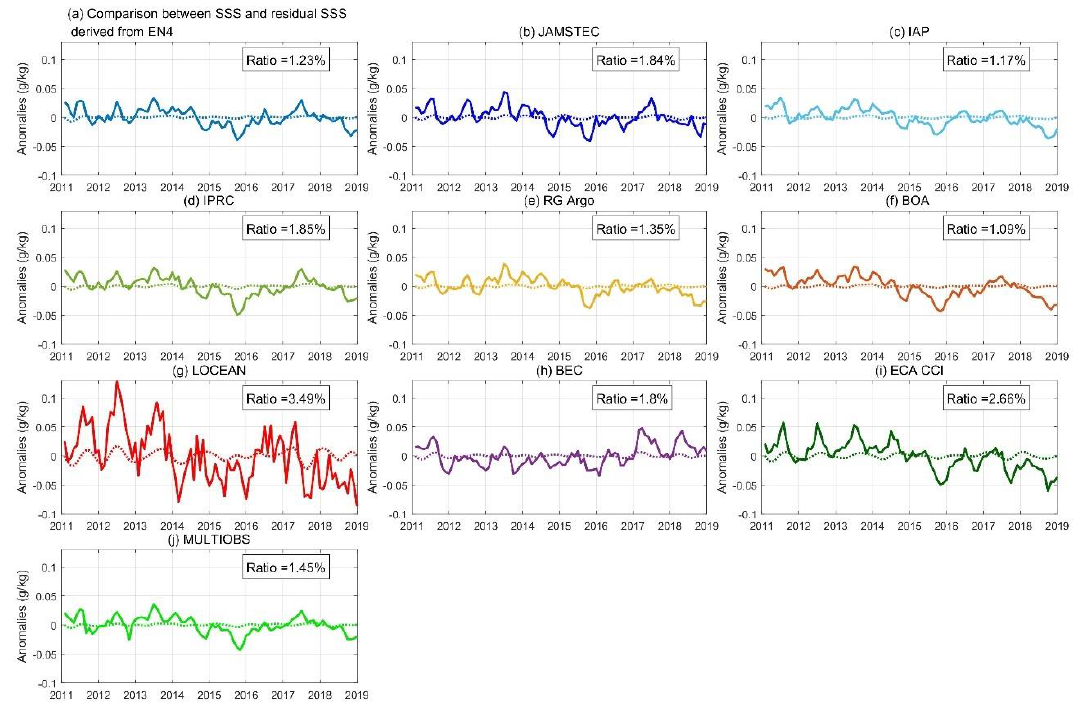
Figure A4. Time series of global mean SSS anomalies (solid lines) and the residual of the decomposed SSS signal (dotted lines) derived from ten SSS products. The ratio of the residual SSS variance to the total SSS variance is listed in the northeast corner of each plot. The units for SSS anomalies are g/kg.